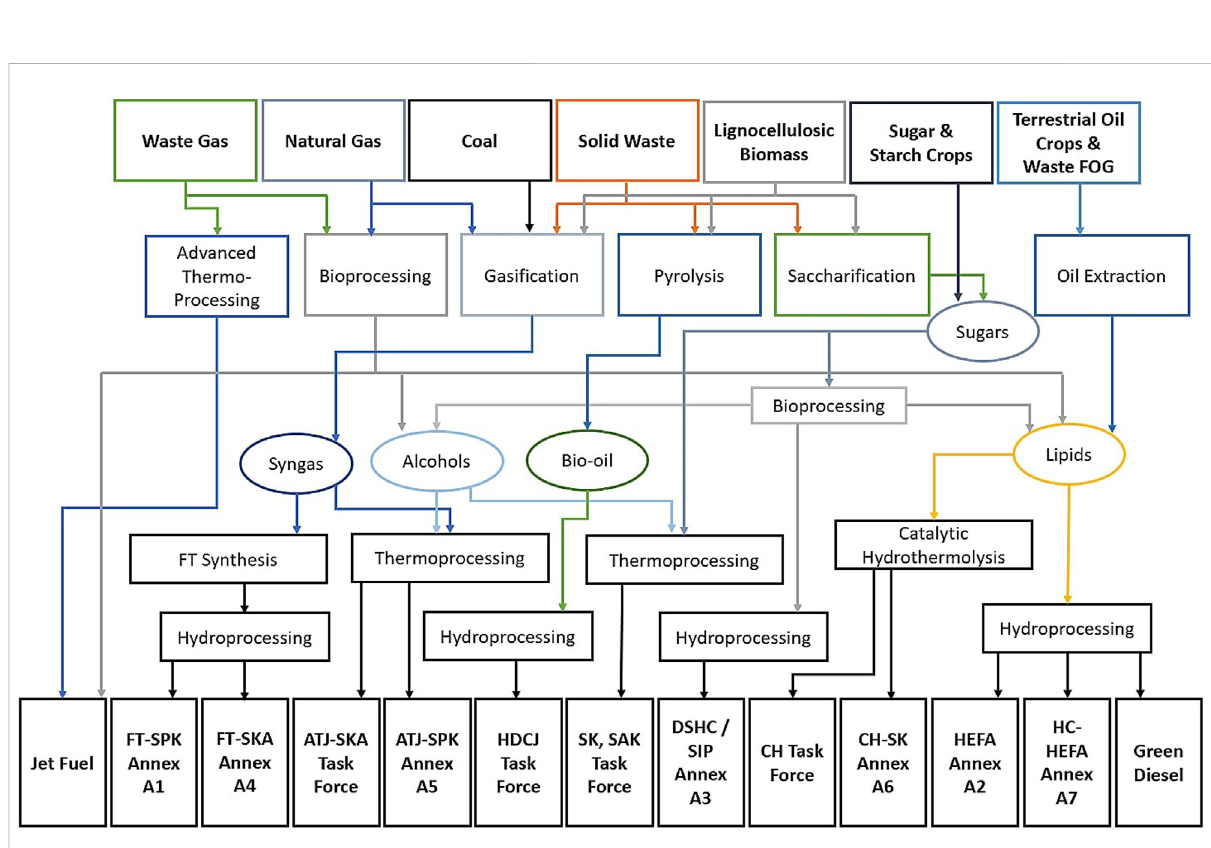
FIGURE 2 SAF pathways [adapted from Brown, Iowa State, 2012 and T. Edwards, USAF/AFRL — ASTM D7566 Task